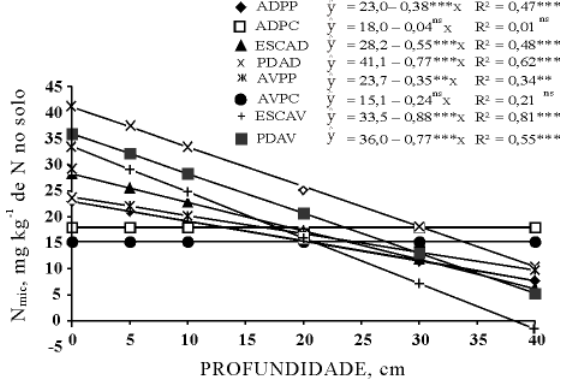
Figura 1. Regressão linear de N de acordo com a mic profundidade do solo para os oito sistemas de manejo, na amostragem antes do